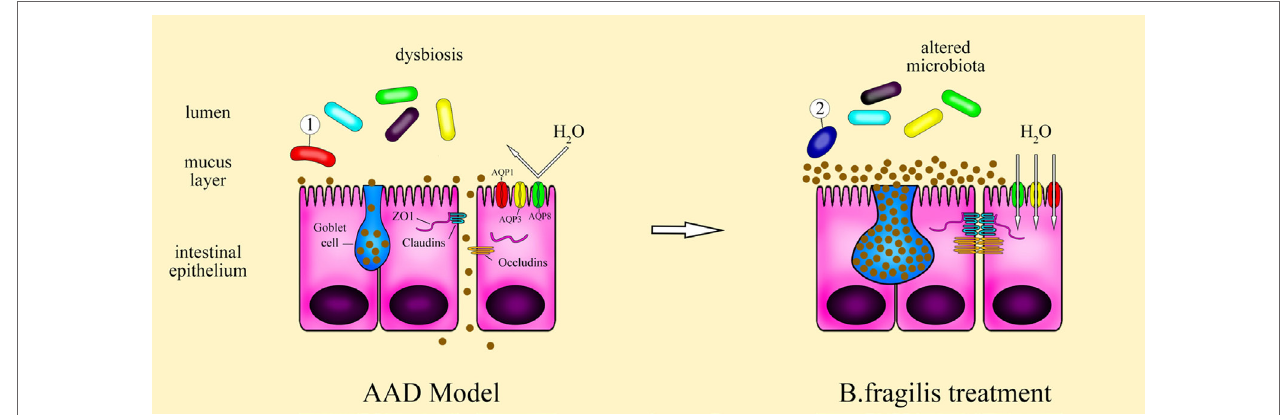
FigUre 7 | Schematic of the therapeutic role of Bacteroides fragilis ZY-312 in AAD symptom. Antibiotic-associated diarrhea (AAD) rats exhibit dysbiosis of the gut microbiota, with overgrowth of some pathogenic bacteria and then resulting in defective gastrointestinal integrity and improper epithelial organization with low aquaporins, aberrant tight junction proteins, and a decreased number of mucus-filled goblet cells. Treatment of AAD rats with B. fragilis ZY-312 alters the composition of the gut microbiota, with promotion of commensal A. muciniphila growth, and subsequently remodeling of the colonic epithelium by improving enterocyte monolayer integrity, increasing mucus layer thickness, and water transport in